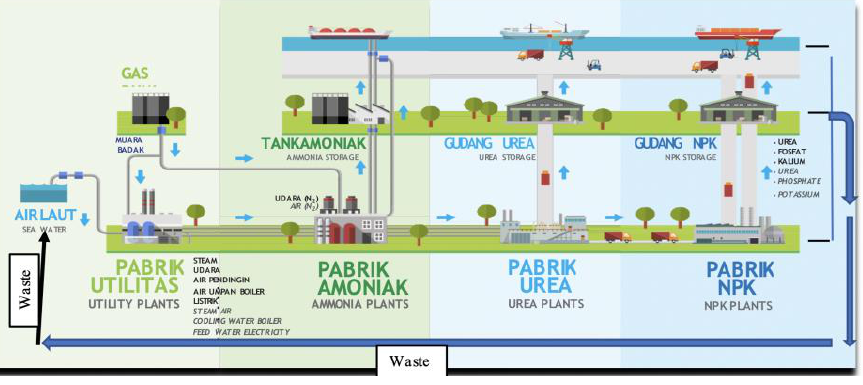
Figure 3: Production Process Flow; Source: SRA, 2018